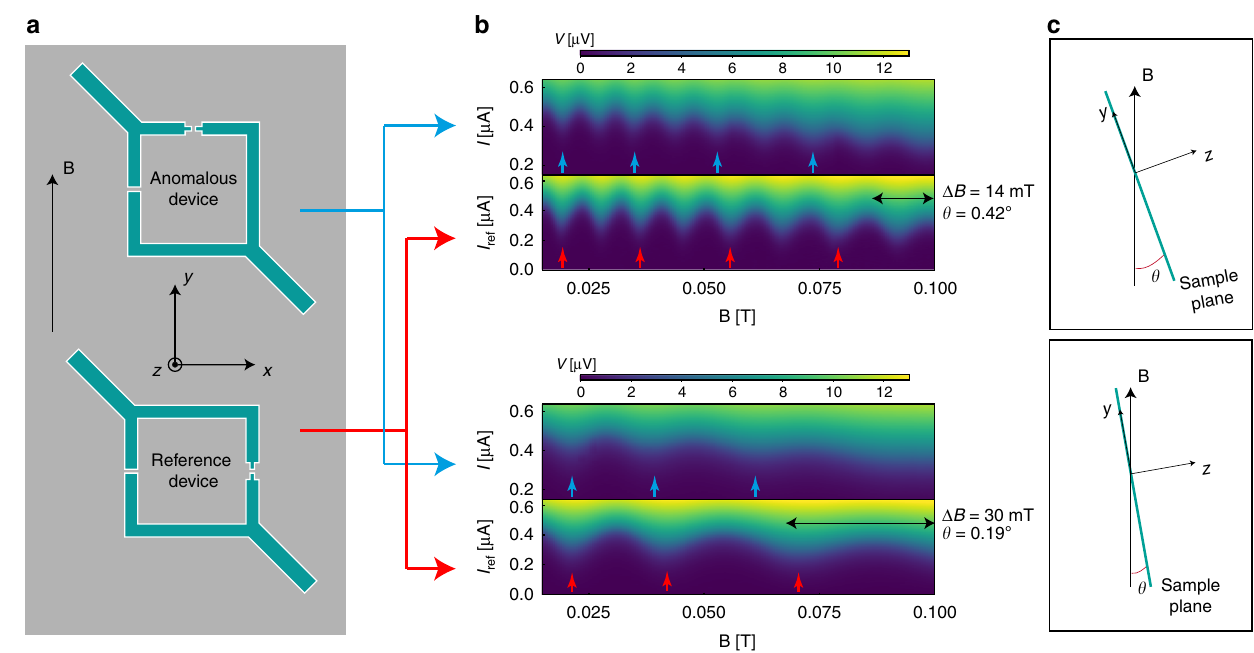
Fig. 4 Probing the anomalous phase shift. a Sketch of the setup consisting of two JIs fabricated on the same chip. The reference and anomalous JIs have ’ 20 : 6 μ m 2 . The Aluminum electrodes are 20 nm thick. From Table 1, in the absence of disorder, an identical area, respectively S and S ref , where S ’ S ref anomalous phase shift induced by Rashba spin-orbit coupling can be generated only by an in-plane magnetic fi eld B y . b Voltage map showing the critical current oscillation of the two devices as a function of magnetic fi eld B. The critical current of both devices oscillate due to the perpendicular component of the magnetic fi eld B z = B sin ( θ ), as sketched panel c . The oscillation frequency can be changed by mechanically tilting the sample, i.e by changing the angle θ between the plane containing the superconducting loop and the magnetic fi eld B. The frequency of the anomalous device is larger than the reference as a consequence of the anomalous phase shift. The colored arrows are guide to the eyes, to help visualizing the increased phase shift in the anomalous device